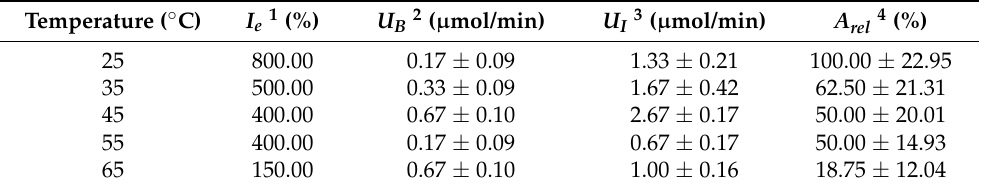
Table 4. Effect of temperature on the lipolytic activity of AA-ANL immobilized onto polyacrylic support